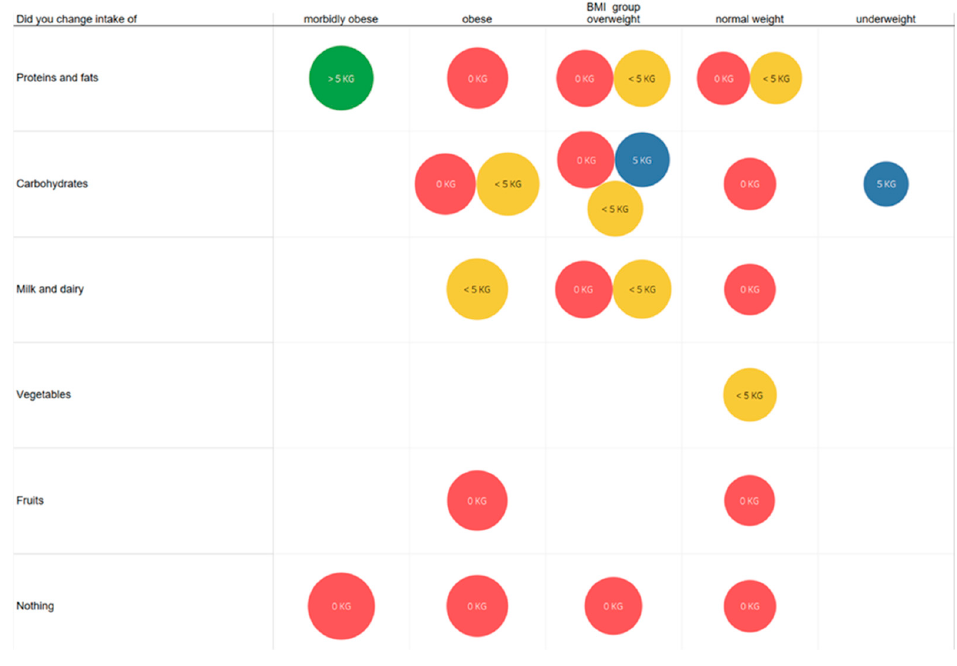
9 of 18 Figure 8. Distribution of users by frequency of intake of macronutrients, milk, and milk products, vegetables, and fruits absolutely and relatively.